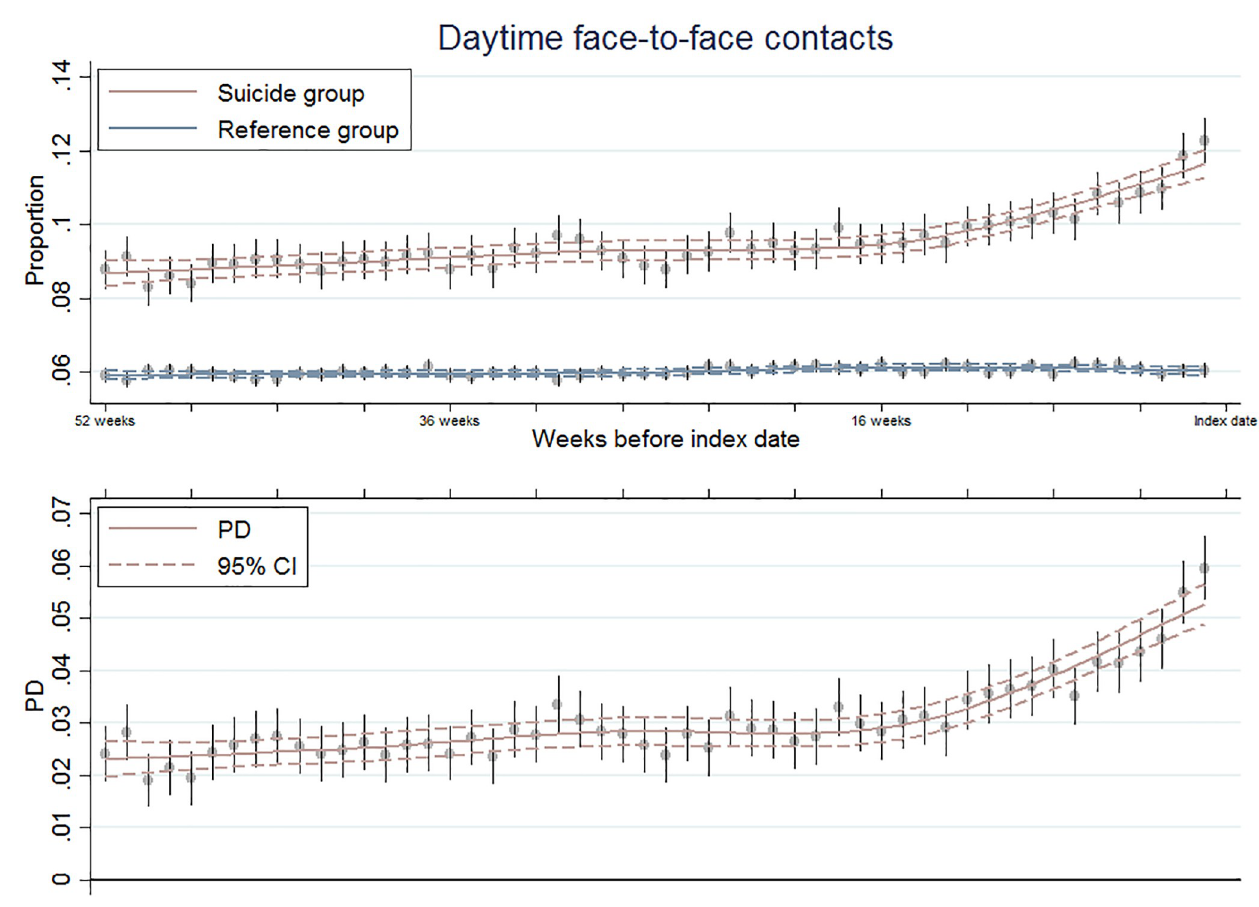
Fig 2. Raw proportion attending the GP and adjusted PD as a function of time. The PD estimates are adjusted for age, sex, calendar period, socioeconomic status, and comorbid somatic